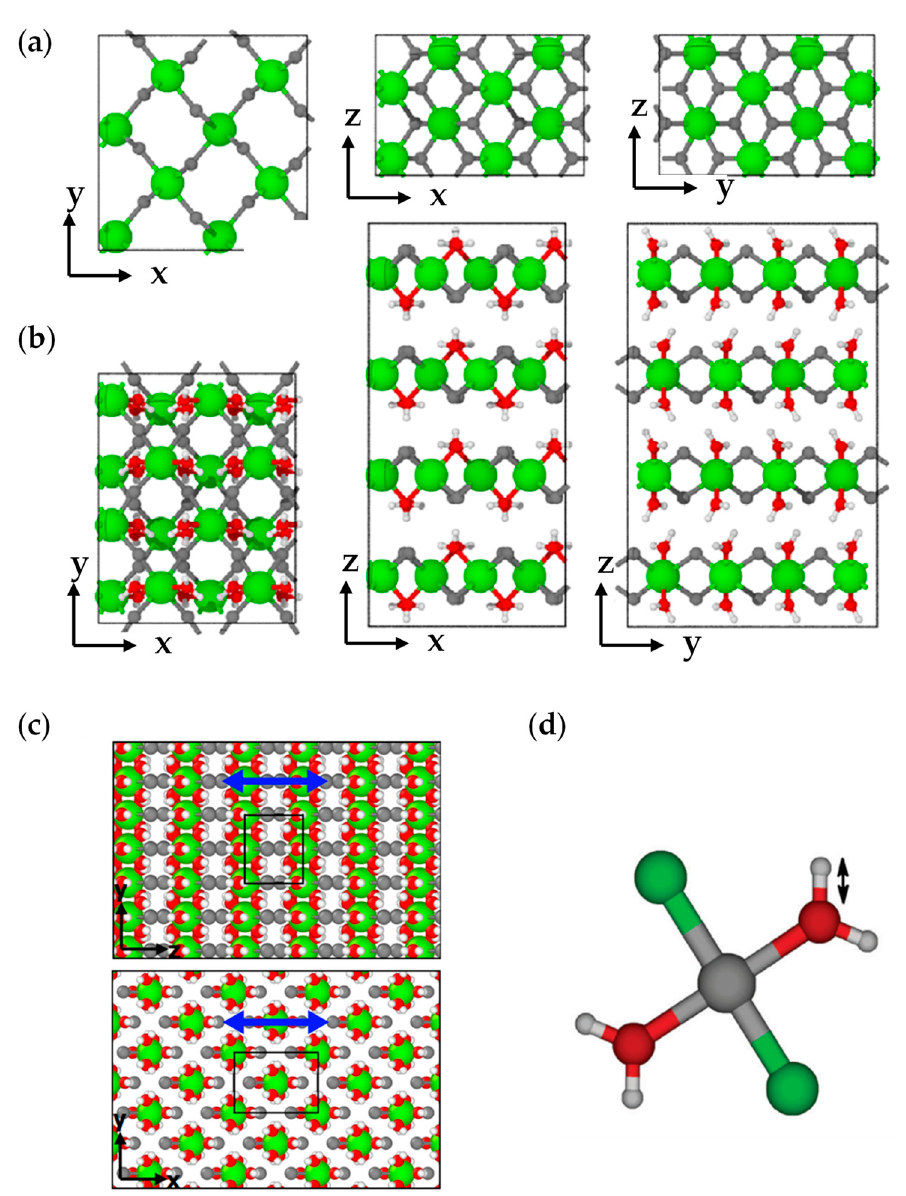
Figure 12. Crystal structure for ( a ) CaCl 2 [91]; ( b ) CaCl 2 · 2H 2 O [92]; ( c ) MgCl 2 · 6H 2 O [93] and ( d )